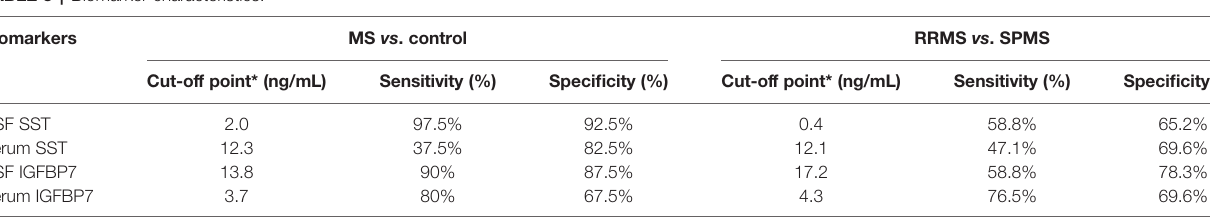
TABLE 3 | Biomarker characteristics.